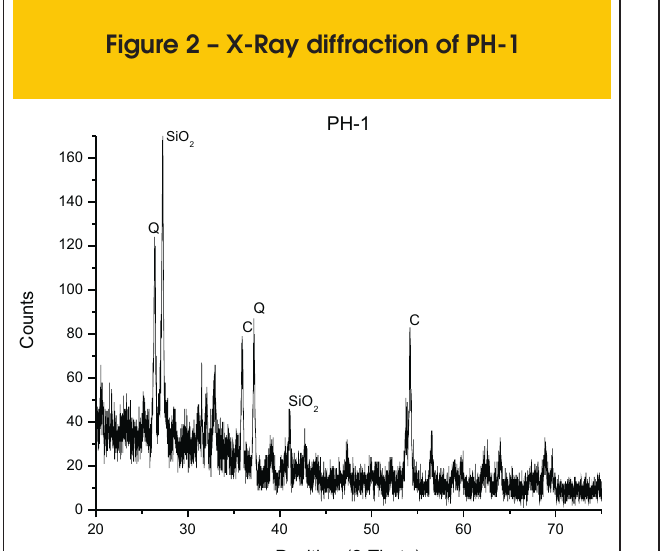
Figure 4 – X-Ray diffraction of